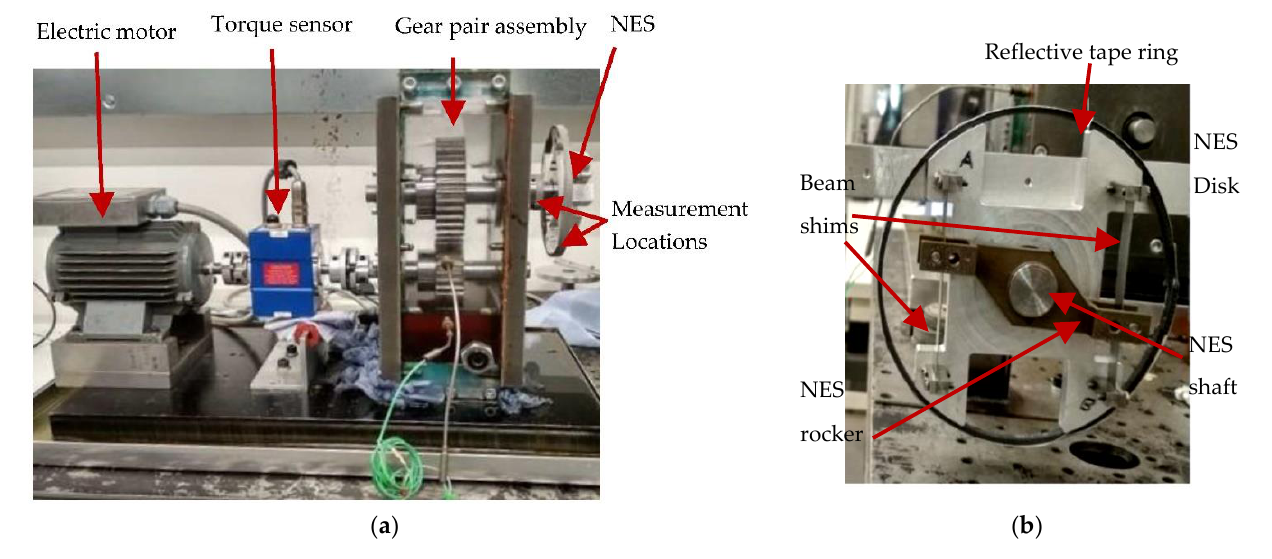
Figure 7. ( a ) Experimental setup; ( b ) NES disk. Table 2. Parameters of the gear assembly.